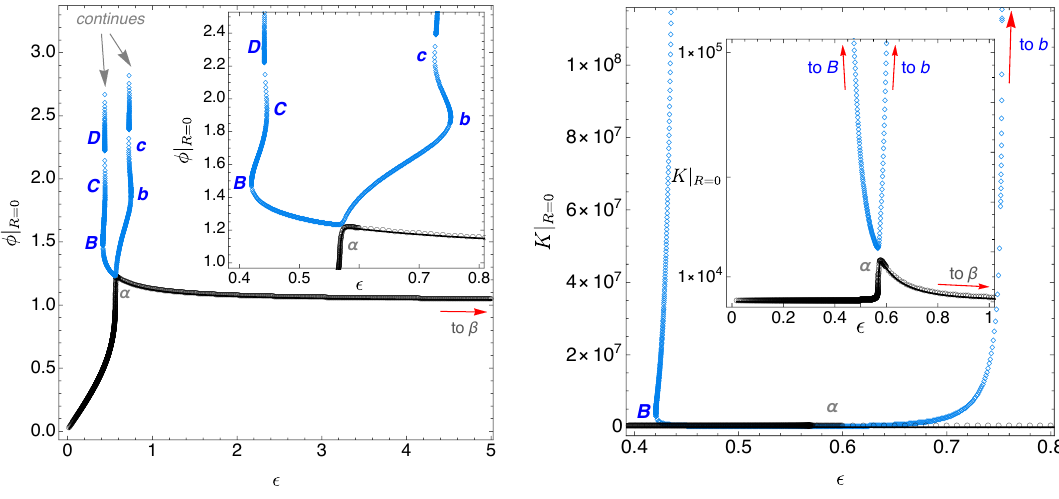
Figure 11 . Soliton families with e = 1 . 855 ( e c < e < e ). Alike in the previous figure, comparing S the current plots with those of figure 8 for the e . e c case, we find major differences: the black disk curve is still the main soliton family but it now extends to arbitrarily large (cid:15) . On the other hand, the secondary soliton family (blue diamond curve) is now confined to a small window of (cid:15) . As e → e + , the gap between the two curves, in the region vaguely signalled as α , decreases until c it vanishes precisely at e = e c . Left panel: core value of the scalar field as a function of (cid:15) with damped oscillations seen in both ends of the secondary soliton family. Right panel: the Kretschmann evaluated at the origin as a function of (cid:15) for both soliton families. Comparing with figure 8 for the e . e c case, we see that now the main soliton family exists for any (cid:15) and its curvature at the